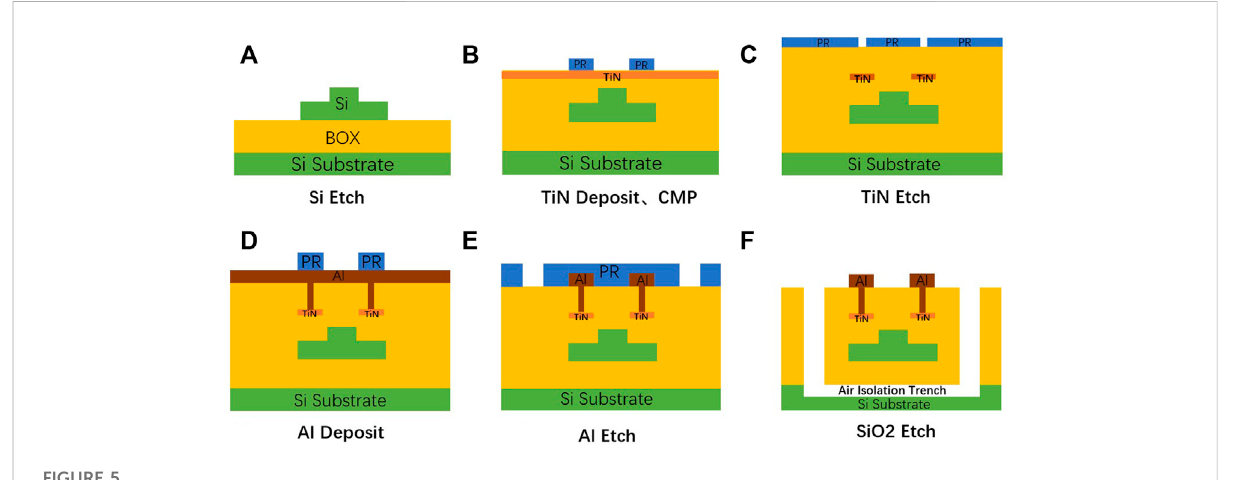
FIGURE 5 The manufacturing process of MRR.